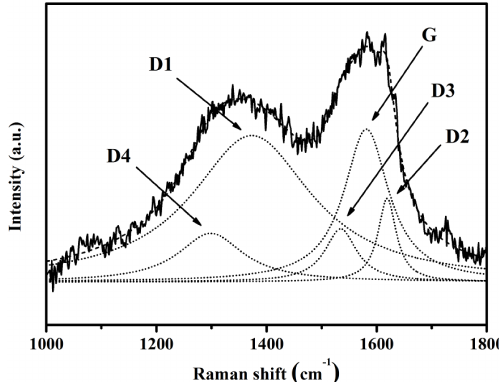
Figure 8. First-order Raman spectra and its mode structure: G and D (D1–D4) modes represents the graphite and the disordered multi modes (see text in details). The black line represents the measured data, while the scattered line represents the fitted